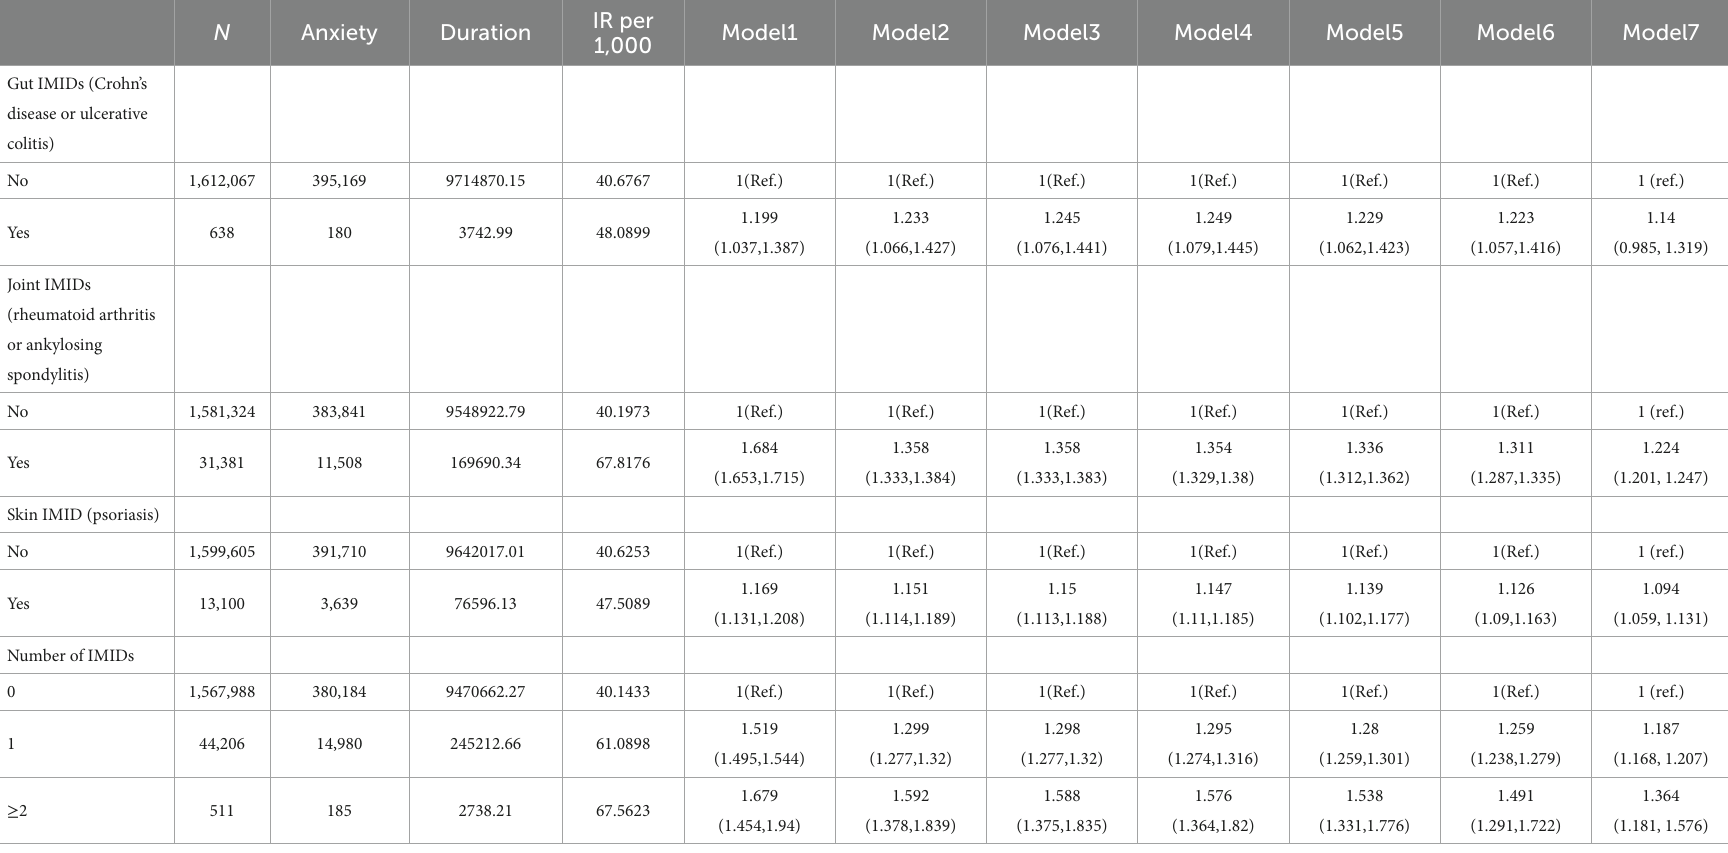
TABLE 4 Risk of anxiety according to the presence of immune-mediated inflammatory